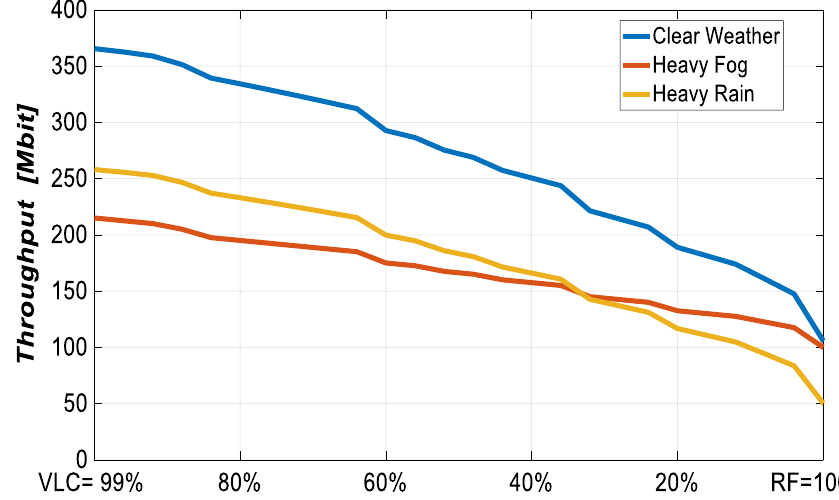
Fig. 8 The throughput at the VLC percentage. The system overall throughput due to the VLC percentage in each simulation versus the RF percentage at different weather conditions. As in Eq. (5), we add or remove the transfer function of each weather condition to study its effect. In clear weather (i.e., only the line-of-sight transfer function is considered), the pure VLC channel communication data rate is about three times that of the pure RF channel communication data